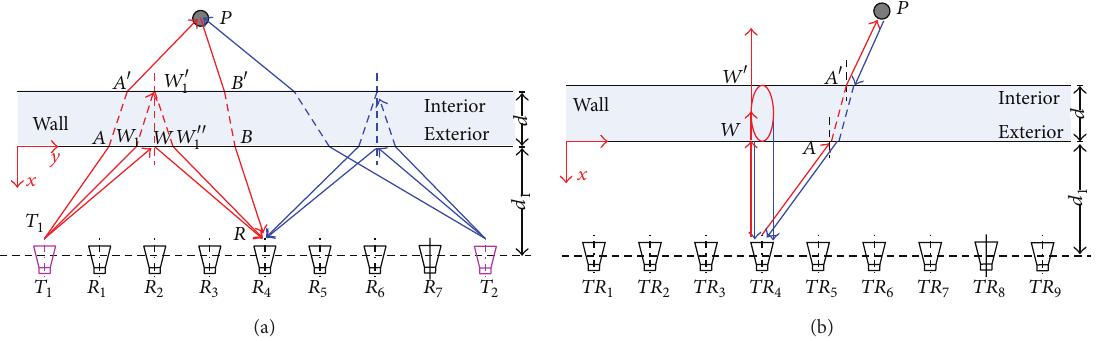
Figure 1: The conventional TWI point target signal models: (a) MIMO mode; (b) monostatic